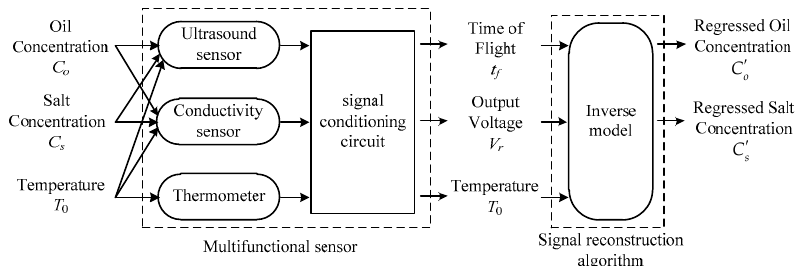
Figure 6. Schematic structure of multifunctional sensing technique.